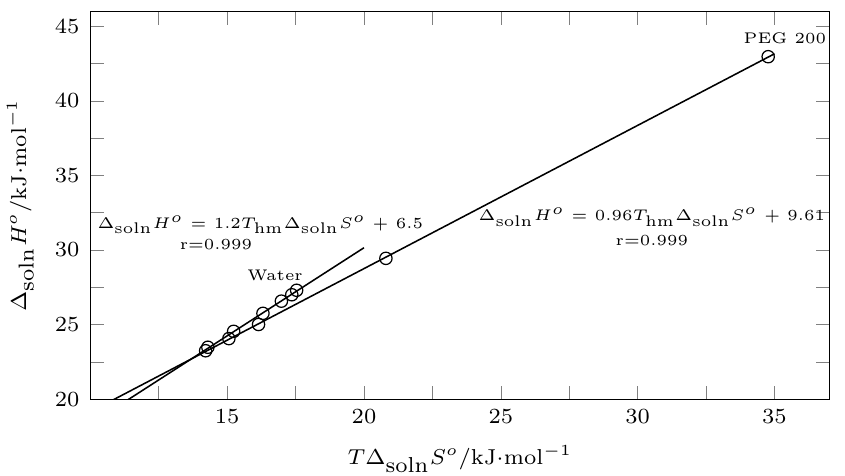
Figure 12. Enthalpy–entropy compensation plot for the solubility of isoniazid (3) in (PEG 200 (1) + water (2)) mixtures at T hm = 297.6